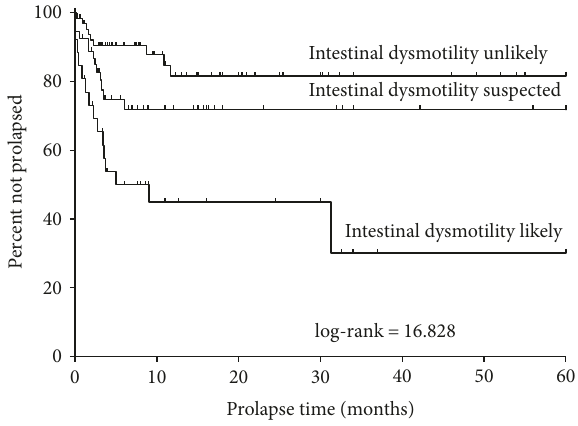
Figure 1: Predicted 5-year (60-month) prolapse for patients with an ileostomy by dysmotility category. Overall, a log- rank test determined that dysmotility category signi fi cantly di ff ered with respect to the rate of prolapse ( χ 2 = 16 828 ; p < 0 001 ). Furthermore, a log-rank test established that con fi rmed dysmotility signi fi cantly di ff ered from suspected dysmotility ( χ 2 = 5 386 ; p = 0 020 ) and unlikely dysmotility ( χ 2 = 16 926 ; p < 0 001 ); however, suspected dysmotility was not found to signi fi cantly di ff er from unlikely dysmotility ( χ 2 = 2 511 ; p = 0 11 ).